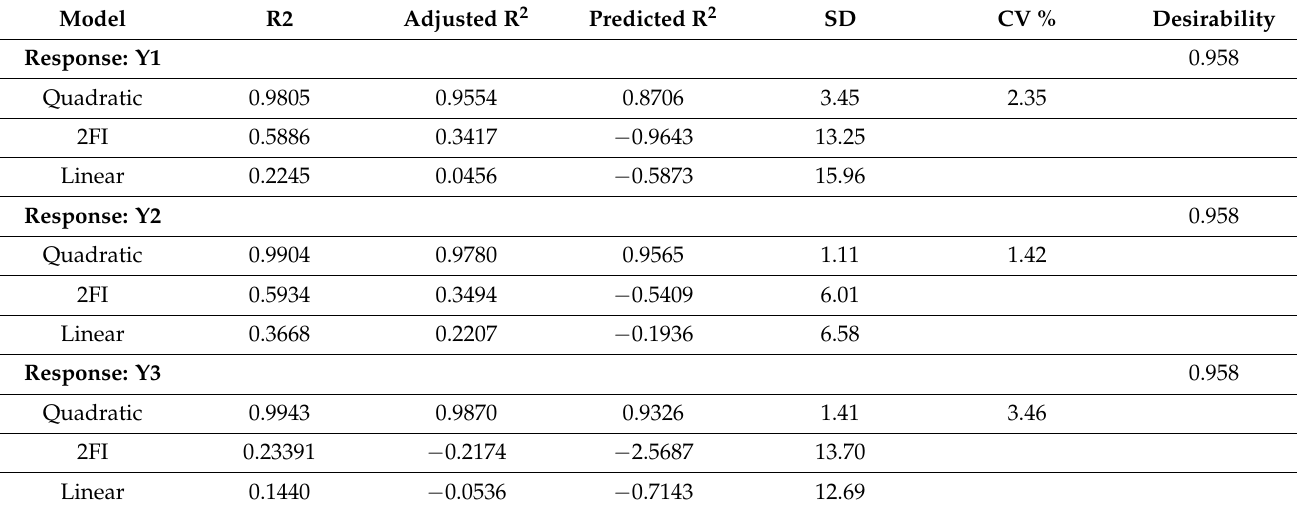
Table 3. Model summary statistics for regression analysis of responses Y1, Y2, and Y3 for data fitting data into various